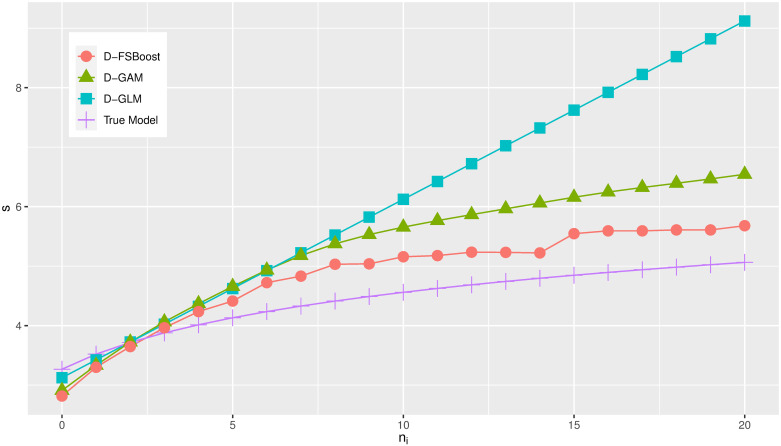
The change of s w.r.t. ni.